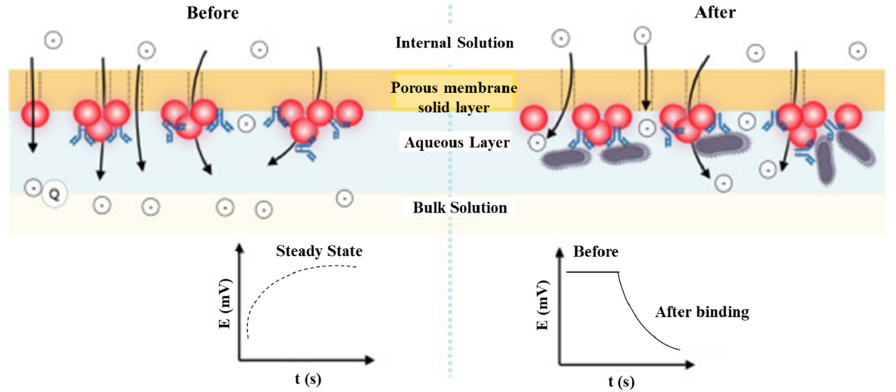
Figure 2. The scheme shows the effect of surface blocking on the ion flux by potentiometric detection in the immunoreacting interface. Redrawn from [23]. © Elsevier